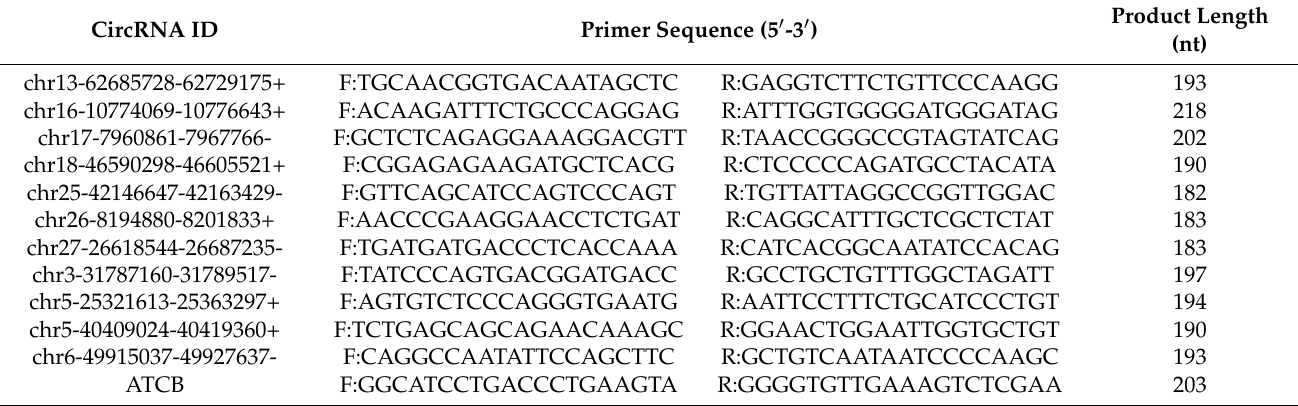
Table 1. Primers for qPCR.